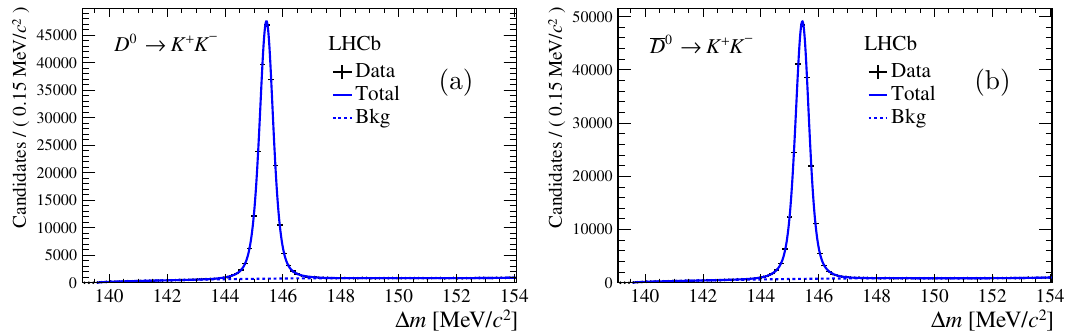
Figure 4 . Results of (cid:12)ts to (cid:1) m distributions of D 0 ! K + K (cid:0) candidates for the MagUp magnet polarity. The (cid:12)ts to (a) D (cid:3) + ! D 0 (cid:25) + candidates and (b) D (cid:3)(cid:0) ! D 0 (cid:25) (cid:0) candidates are shown. The black points represent the data, the dashed blue and solid blue curves represent the background component and the total (cid:12)t function,